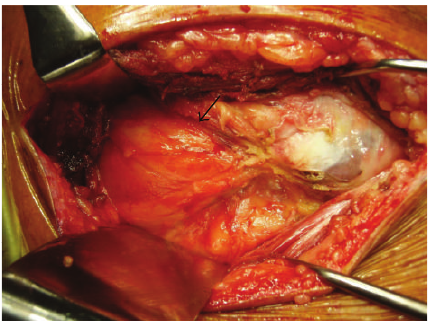
Figure 3: Intraoperative photograph showing yellowish gluteus medius muscle (arrow), which had flaccid tone.